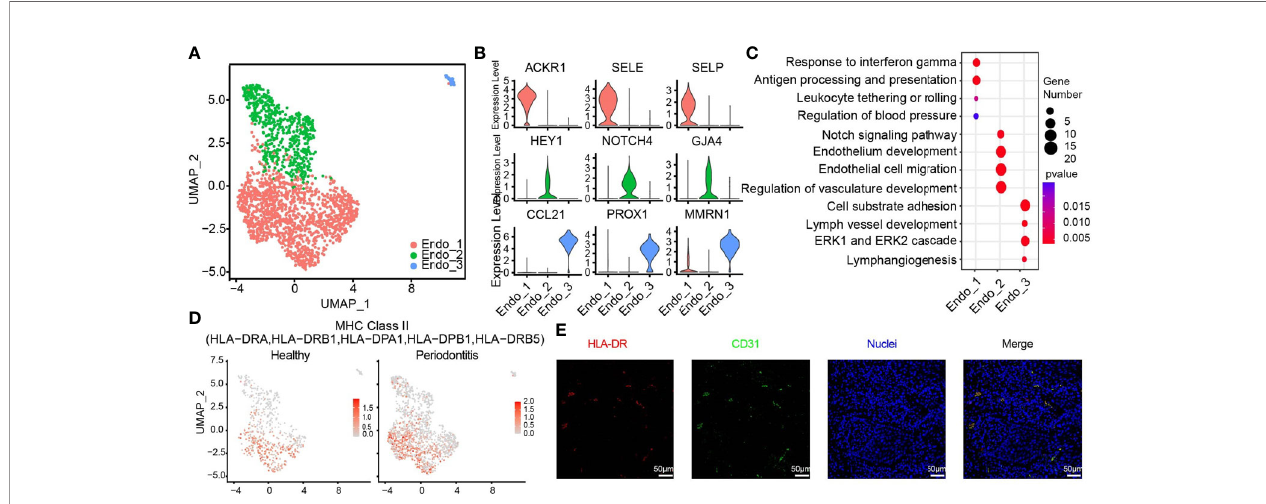
FIGURE 4 | HLA-DR expressing endothelial subcluster in human gingiva. (A) UMAP visualization of endothelial subclusters in the combined health ( n = 2; 596 cells) and periodontitis ( n = 2; 1,363 cells) dataset. (B) Violin plots showing expression levels of cluster-de fi ning genes for endothelial subsets. Expression values are normalized and scaled averages. (C) Dot plots showing the enriched gene ontology biological process terms for each endothelial cluster. (D) The expression of HLA- DR was projected on the UMAP plot. Red indicates maximum gene expression, while grey indicates low or no expression. The gene expression levels are normalized and transformed as ln (CPM/10). (E) Immuno fl uorescence assay for the MHC class II marker HLA-DR (red) and the endothelial cell marker PECAM1 (CD31, green) and with DAPI (blue) in the subepithelial region. Scale bar: 50 m